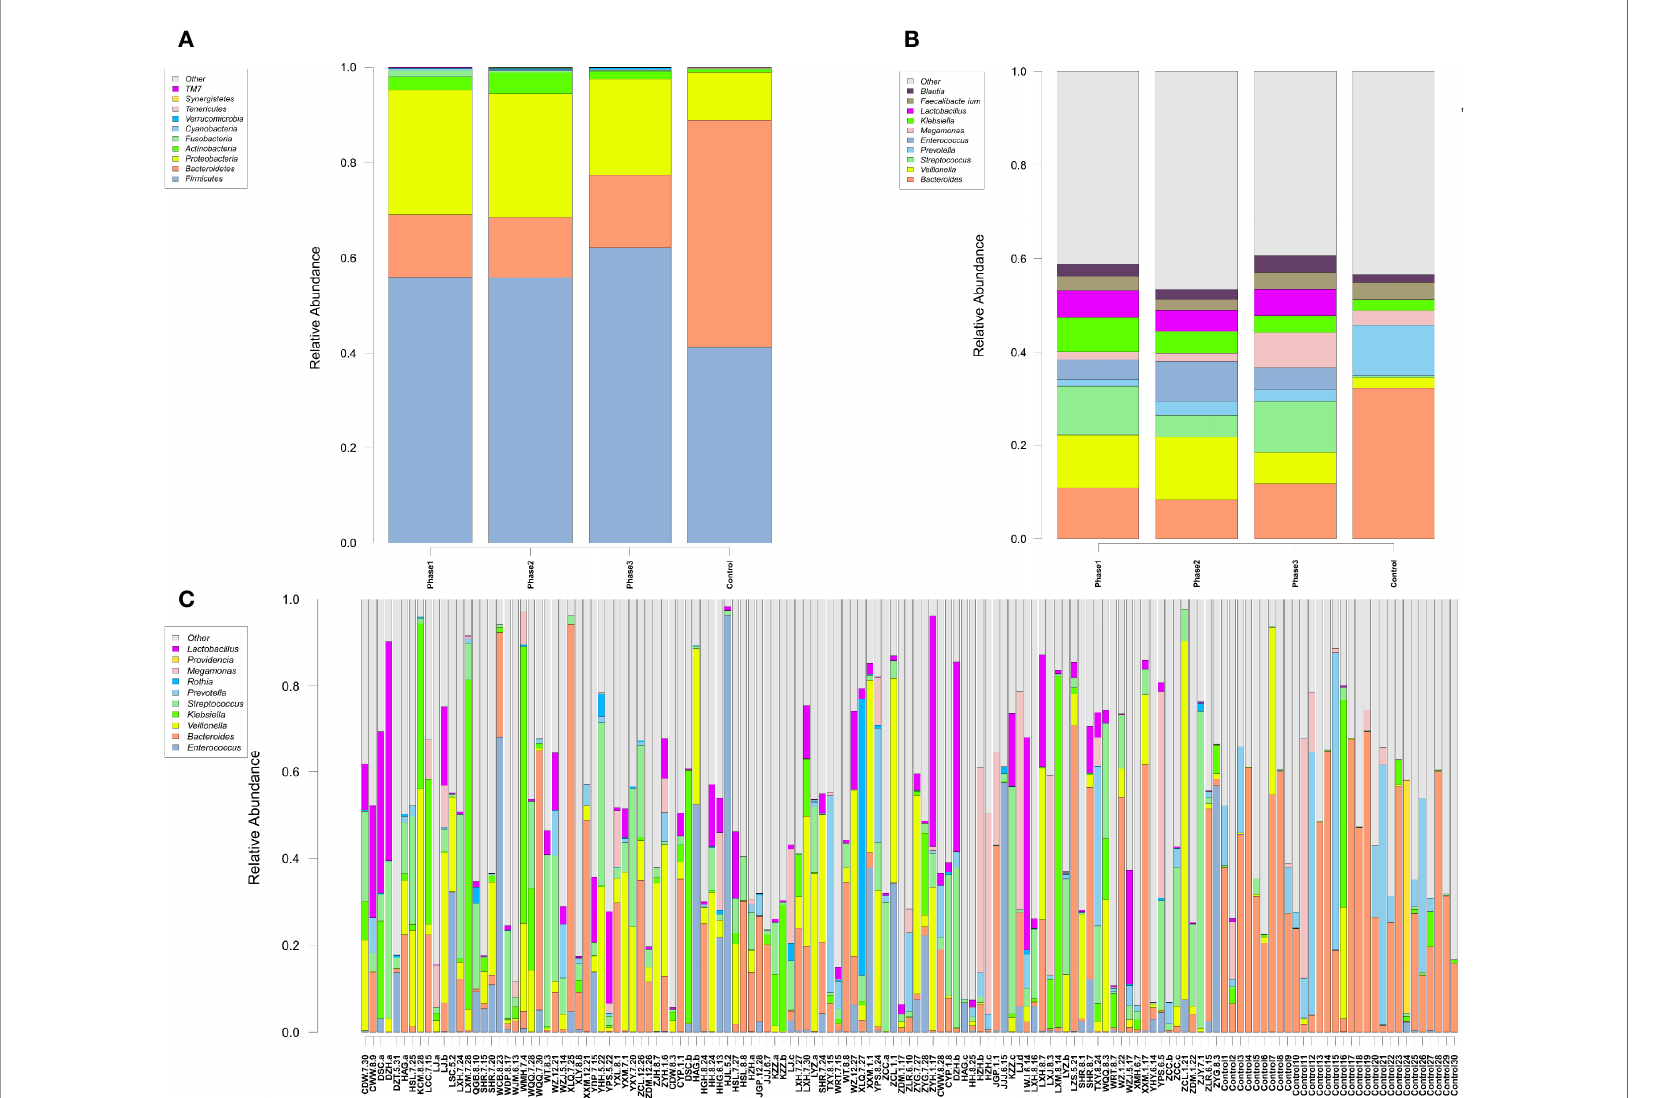
FIGURE 1 | Characteristics of gut microbiota composition. (A) Relative abundance of microbial communities at the phylum level. Phase 1: rising stage; Phase 2: plateau stage; and Phase 3: recovery stage. (B) Relative abundance of microbial communities at the genus level. Phase 1: rising stage; phase 2: plateau stage; and phase 3: recovery stage (C) Relative abundance of all 109 samples at the top 10 genus level. (Individuals are shown along the horizontal axis, and relative taxa proportions are represented by the vertical axis. The X-axis showed the each sample, the naming principle of samples were the initials of the patients ’ name added with the sampling